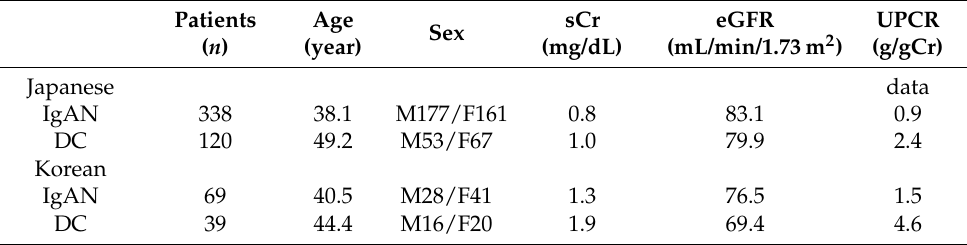
Table 1. Clinical characteristics of patients with IgAN and disease controls at the time of renal biopsy.